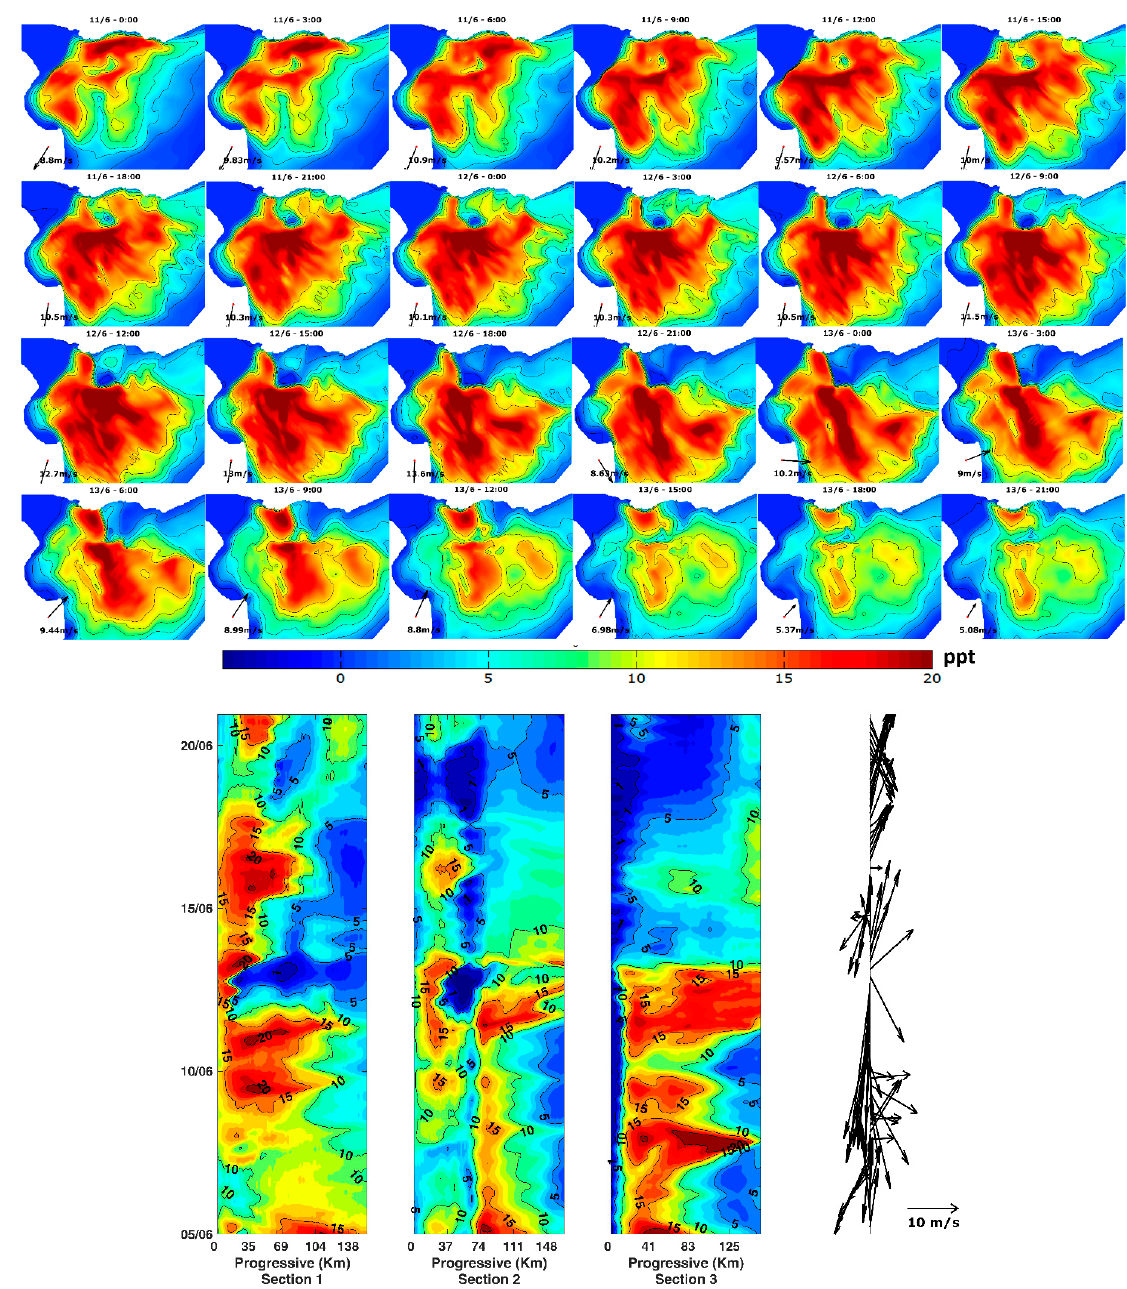
Figure 12. Stratification for a storm with main wind direction from the northeast, which occurred in June 2014. Upper panel: temporal evolution of the stratification field (ppt; time step 3 h). Time increasing from left to right and upper to lower panels. All maps are in geographic coordinates between Lat ( − 36.9, − 34.7) and Long ( − 57.4, 54.2). Lower panel: Hovmoller diagram along longitudinal sections defined in Figure 7; wind evolution on the right. Y-axis shows the date (dd/mm).